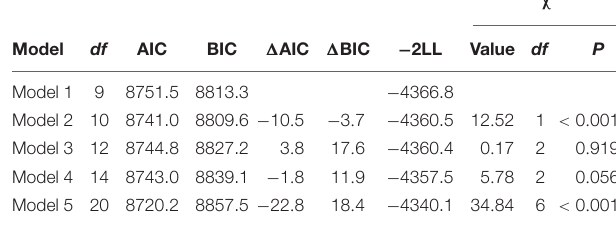
TABLE 3 | Model comparisons.